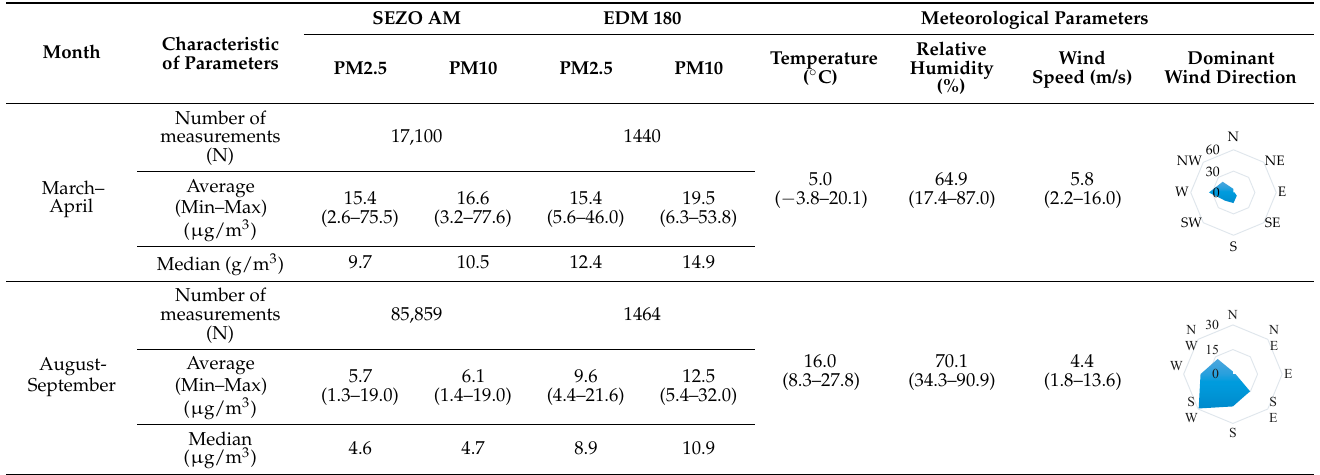
Table 2. Estimators of PM2.5 and PM10 concentrations (µg/m 3 ) and meteorological parameters measured by SEZO AM and EDM 180 in Gdynia Port in the period 1 March–30 April 2021 and 1 August–30 September 2021.